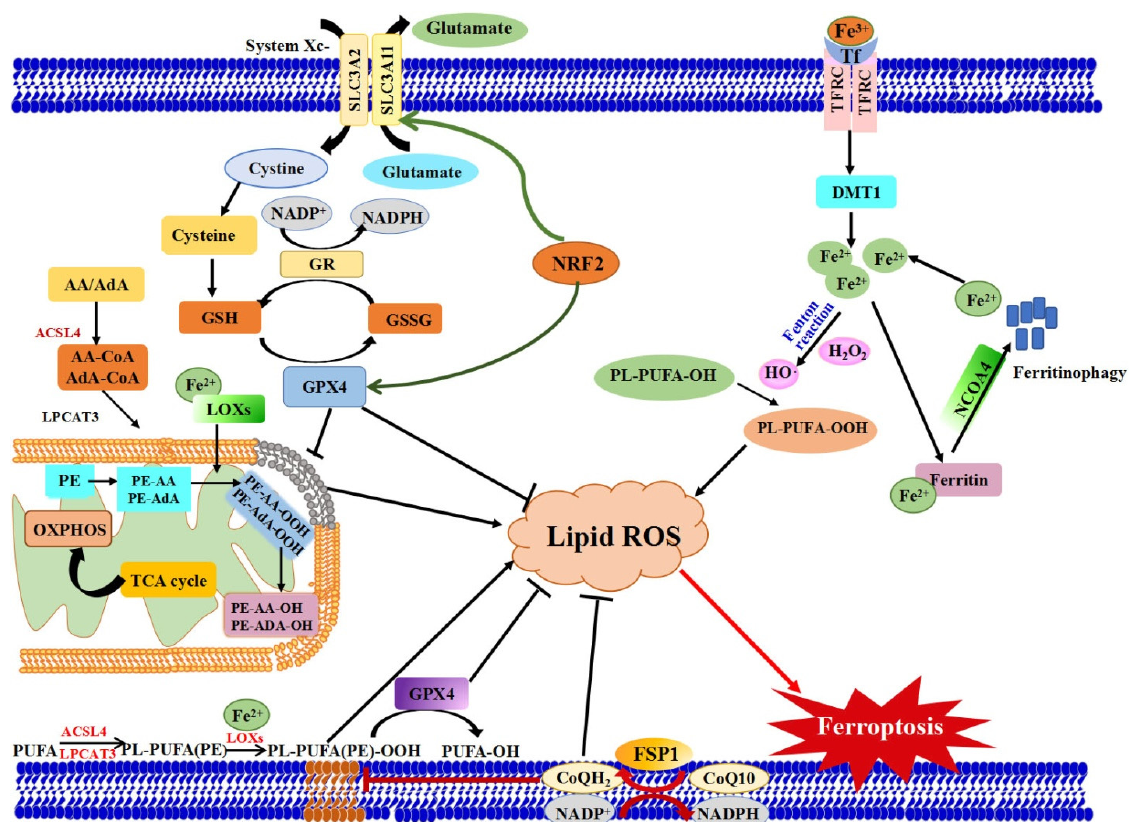
Figure 1. Schematic view of the molecular pathways of ferroptosis regulation. Three main metabolic pathways are GSH/GPX4 pathway, lipid peroxidation and iron metabolism pathways. Ferroptosis is initiated by the suppression of system Xc − and depletion of GSH, or inhibition of GPX4, which results in cell death. Lipid ROS is in charge of the process of ferroptosis. The peroxidation of PUFAs is identified as a vital contributor. Excess iron is the basis for ferroptosis execution. In addition, the latest researches have revealed that the FSP1-CoQ10-NAD(P)H pathway with its unique mechanistic properties engages in ferroptosis. AA: Arachidonic acid, ACSL4: Acyl-CoA Synthetase Long Chain Family Member 4),